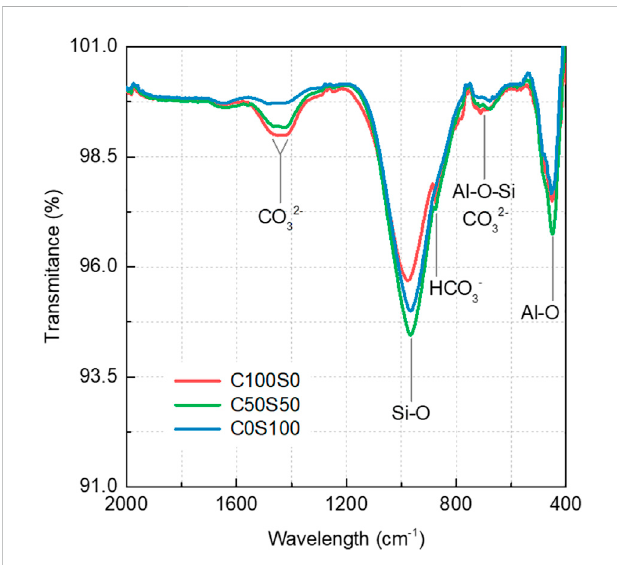
FIGURE 7 Results of FTIR analysis of SH-UHPGC pastes with different activators.